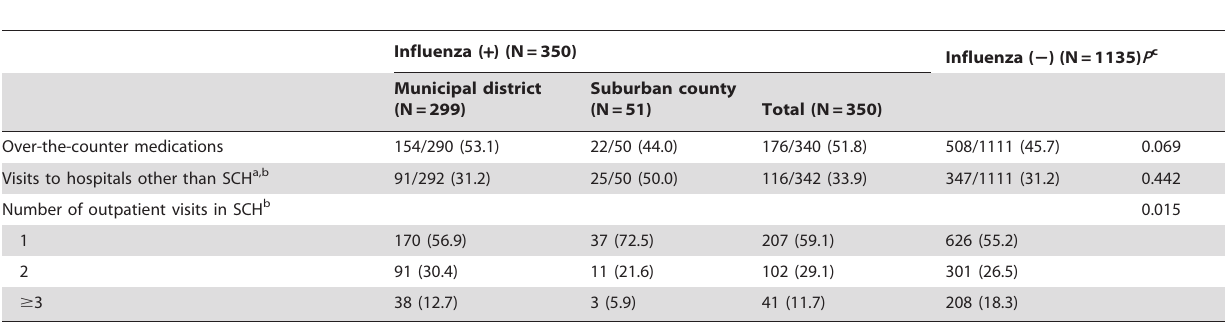
Table 2. Medical seeking behaviors of influenza-like illness (ILI) cases, by influenza virus status and district, n (%).